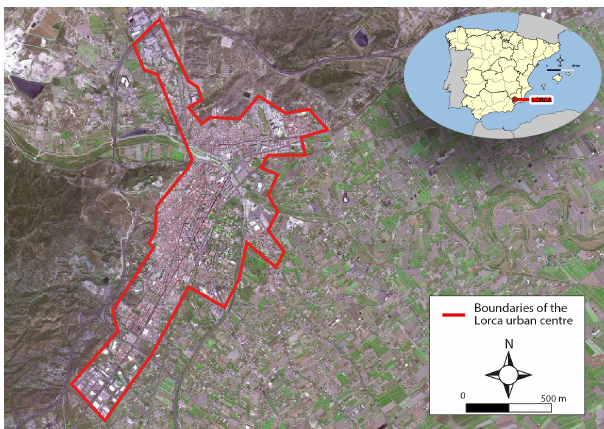
Figure 1. Location of Lorca (inset) and view of the city centre. SPOT source courtesy of the ©Instituto Geográfico Nacional de Es-